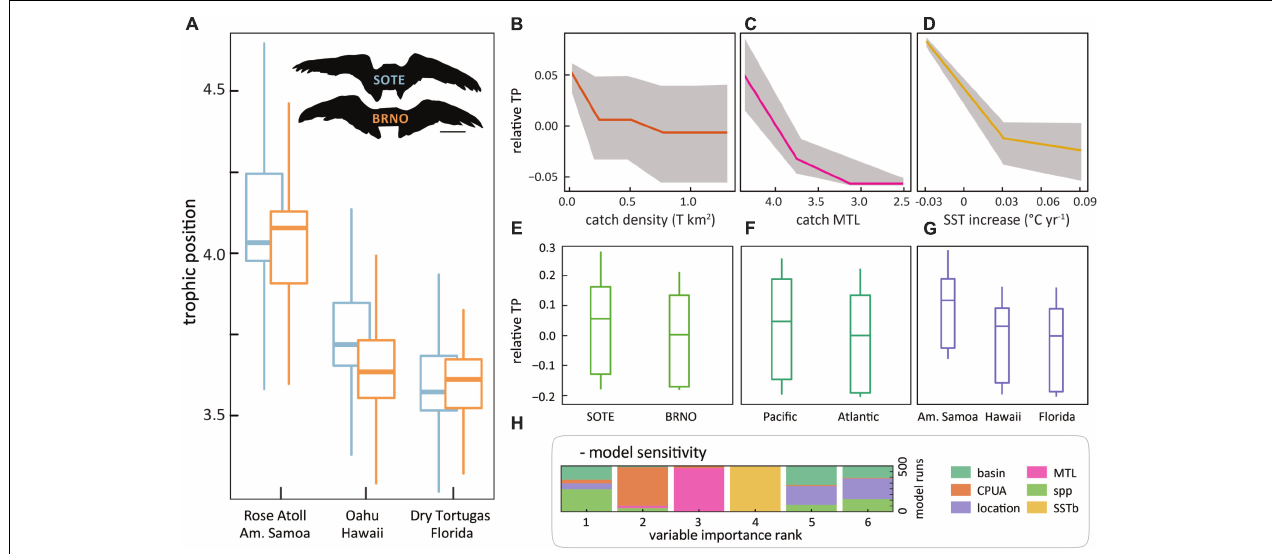
FIGURE 1 | Trophic position of two seabirds (A) and conditional relationships with model predictors (B–G) . A, whisker range is 1.5 × the interquartile spread. Plot colors correspond to labeled wing silhouettes, “SOTE” is sooty tern and “BRNO” is brown noddy. B–G are conditional expectation plots of predictors from the model for continuous (B–D) and categorical model inputs (E–G) . Relative TP on the y-axis of B–G refers to the change in trophic position units observed across the range of values of a predictor. Colored lines (B–D) and center quantile (E–G) represent the respective mean and median of the partial effect of a covariate on the model prediction of TP. Gray bands and quartiles represent the range and distribution of predictions, akin to a prediction interval. TP declines with increases in catch density (B) and rates of SST increase (D) , and declines as Sea Around Us reported catch landings MTL decreases (C) . We assessed model variable importance with a leave one out sensitivity analysis. Panel (H) shows the proportion of model runs where each covariate appeared at each importance rank. Beyond the splitting power of species and geography, fisheries related factors rank